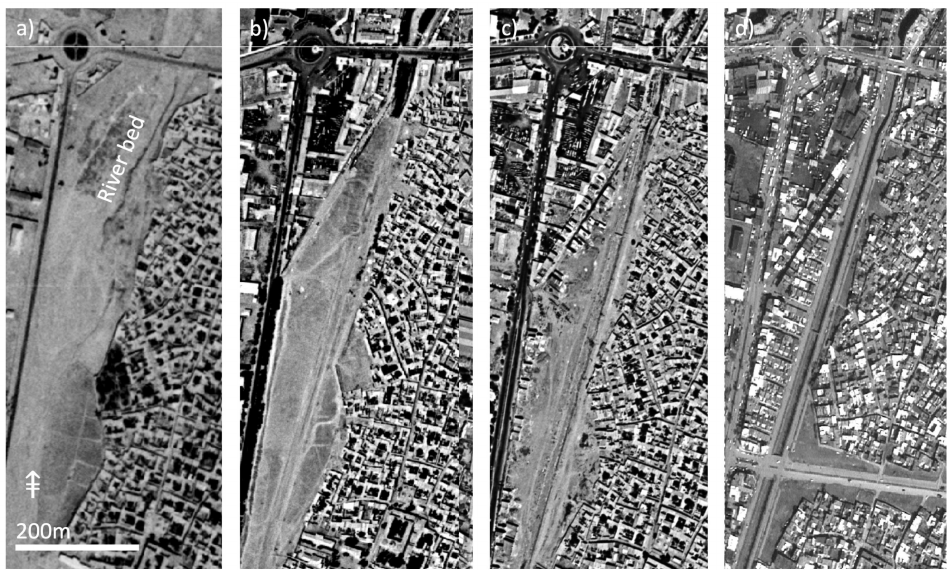
Figure 7. Qazvin,Iran. Urbanareaaroundariverbedin( a )1955,( b )1974,( c )1978and( d )2005.(Data:Table3).